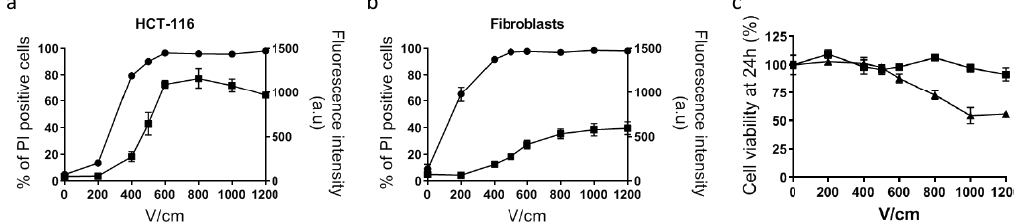
Figure 1. Determination of optimal voltage leading to reversible cell electropermeabilization. Cell electropermeabilization assessed by flow cytometry in HCT-116 tumor cells ( a ) and normal dermal fibroblasts ( b ), n = 3. Circles indicate the % of cells labeled with propidium iodide used as a marker of plasma membrane permeabilization. Squares indicate the mean fluorescence intensity (arbitrary units) of positive cells to propidium iodide. ( c ) Cell viability quantified with PrestoBlue assay based on cell metabolism, 24 h after application of electric pulses. Squares: fibroblasts; triangles: HCT-116; n = 3.